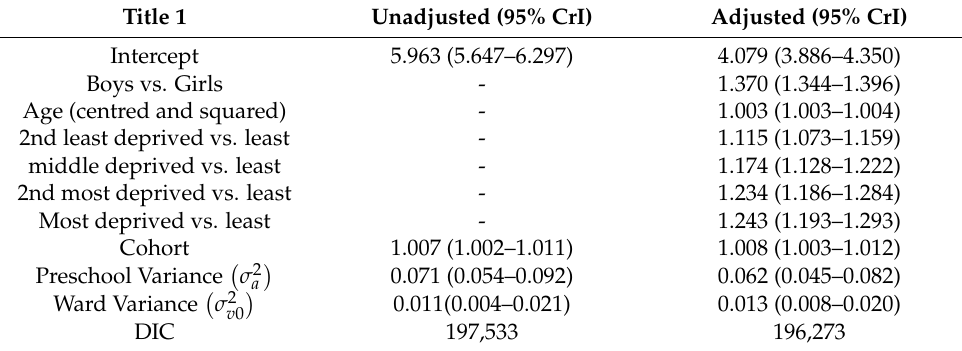
Table 3. Multilevel model.